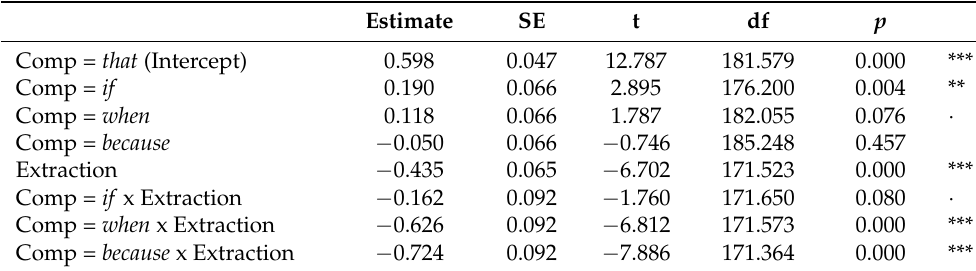
Table 7. Summary of the mixed effects model of Complementizer and Extraction ( z -transformed ratings, target sentences (adjunct islands)), using that as intercept. *** p < 0.001, ** p < 0.01, marginal: · p <